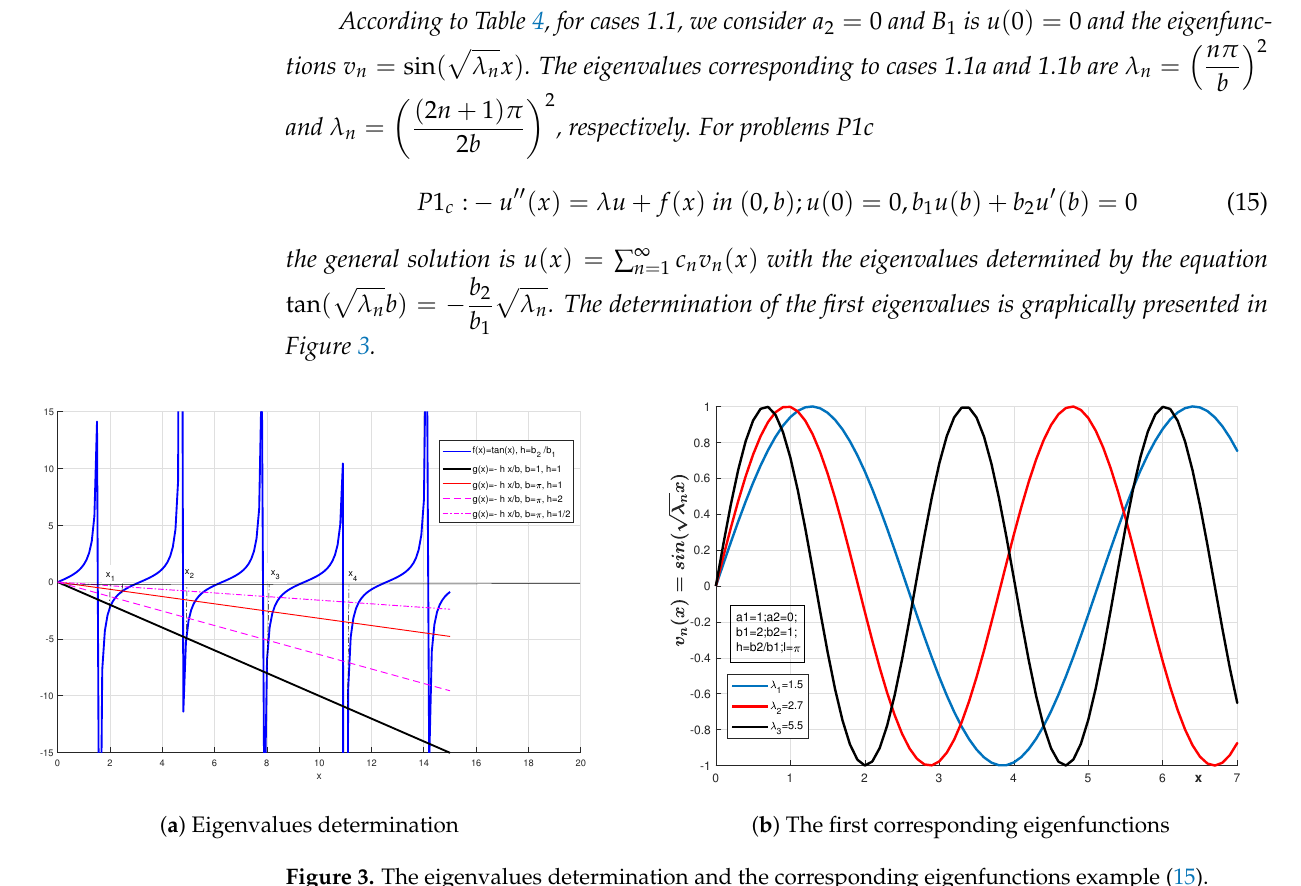
Figure 3. The eigenvalues determination and the corresponding eigenfunctions example